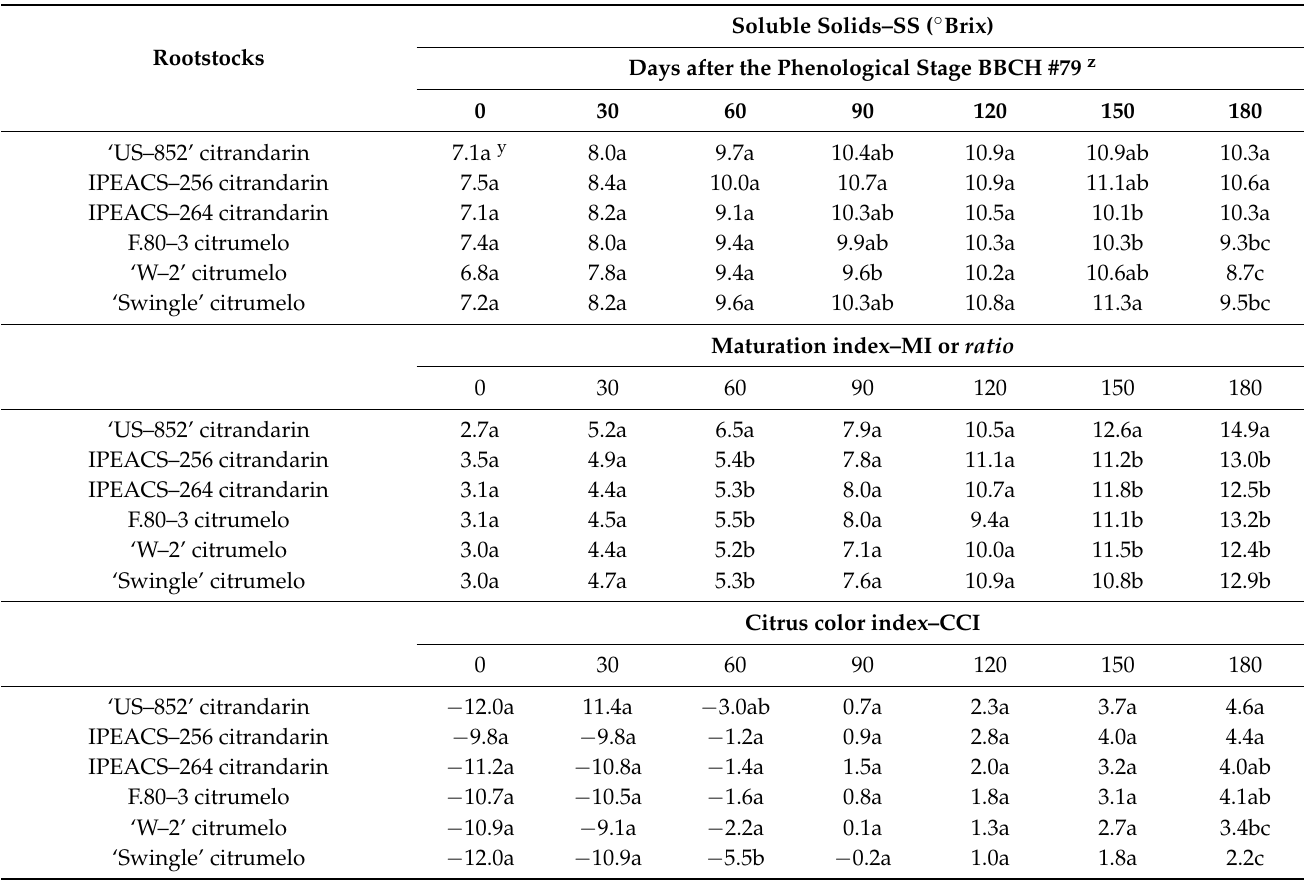
Table 4. Soluble solids, maturation index or ratio , and citrus color index of ‘Valencia’ orange fruits when trees are grafted on different ‘Trifoliata’ hybrid rootstocks at S ã o Sebasti ã o da Amoreira at different times after the phenological stage BBCH #79.